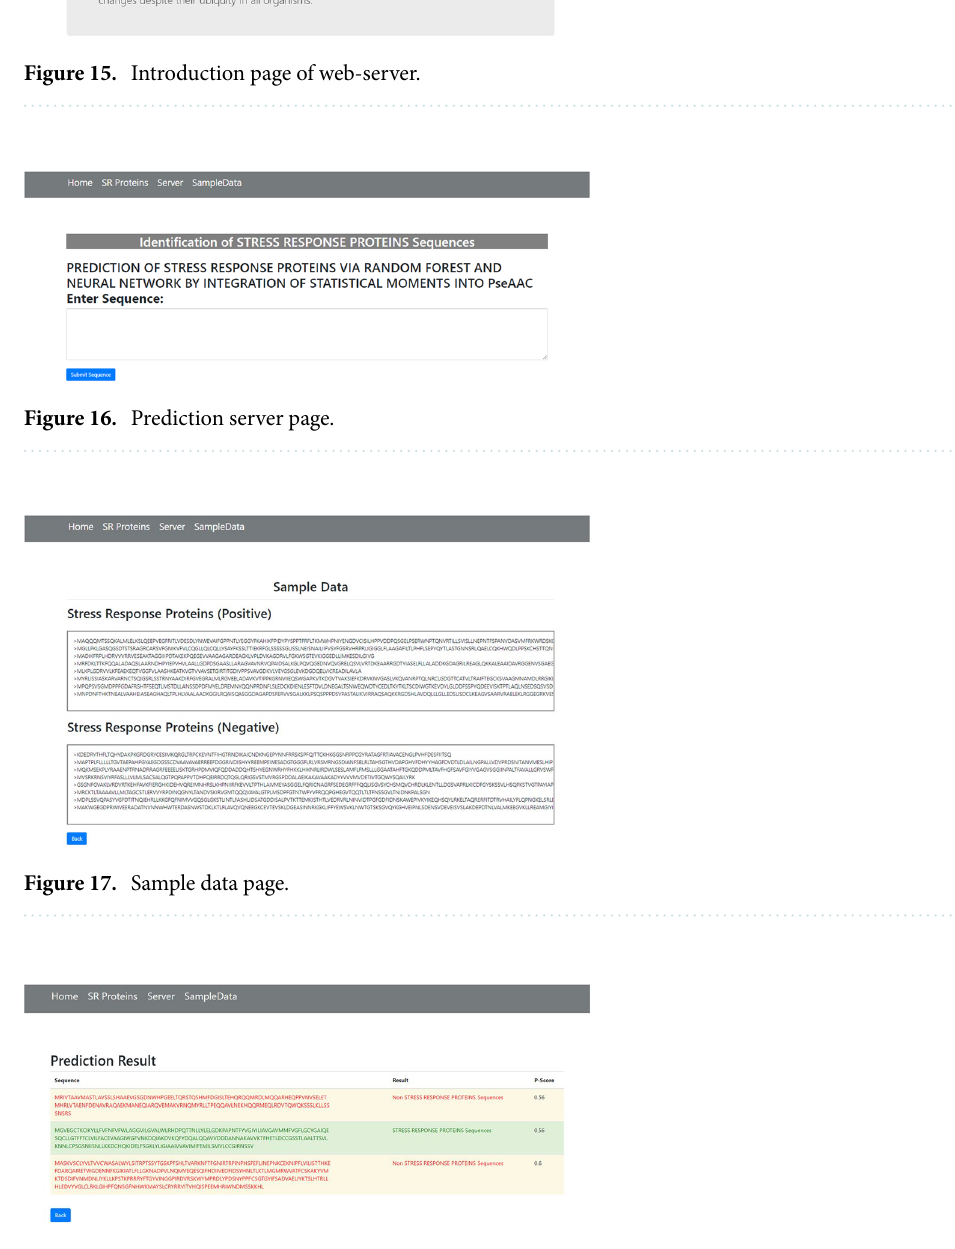
Figure 18. Results page of